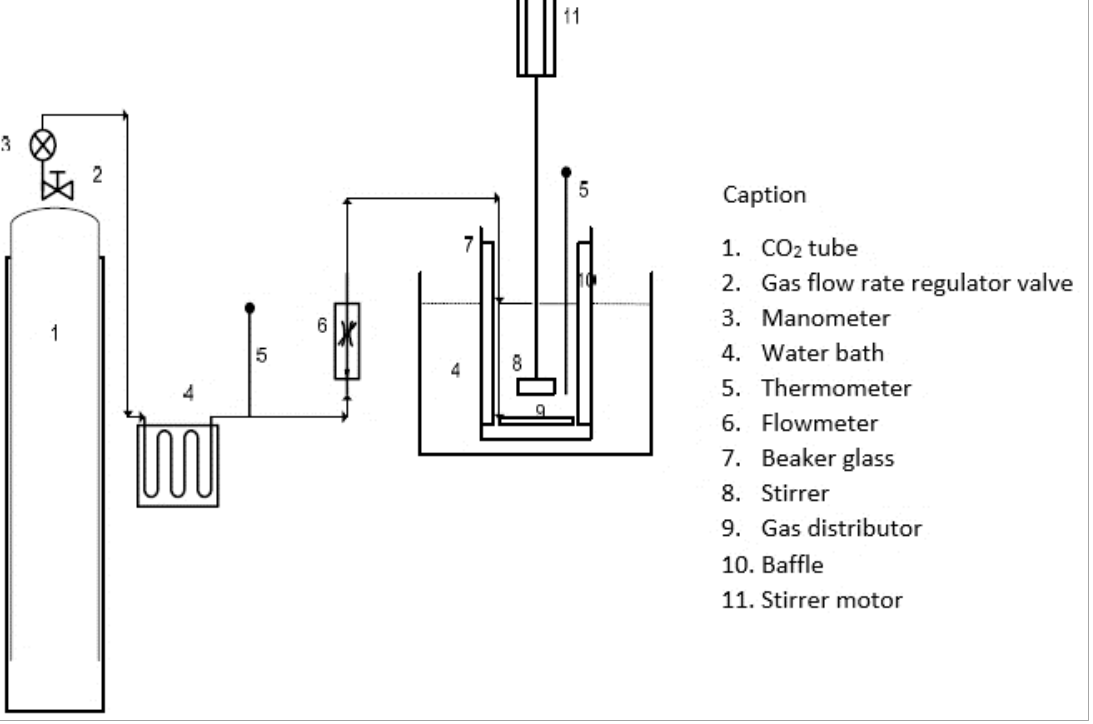
Figure 1. A scheme of experimental setup using a stirred tank